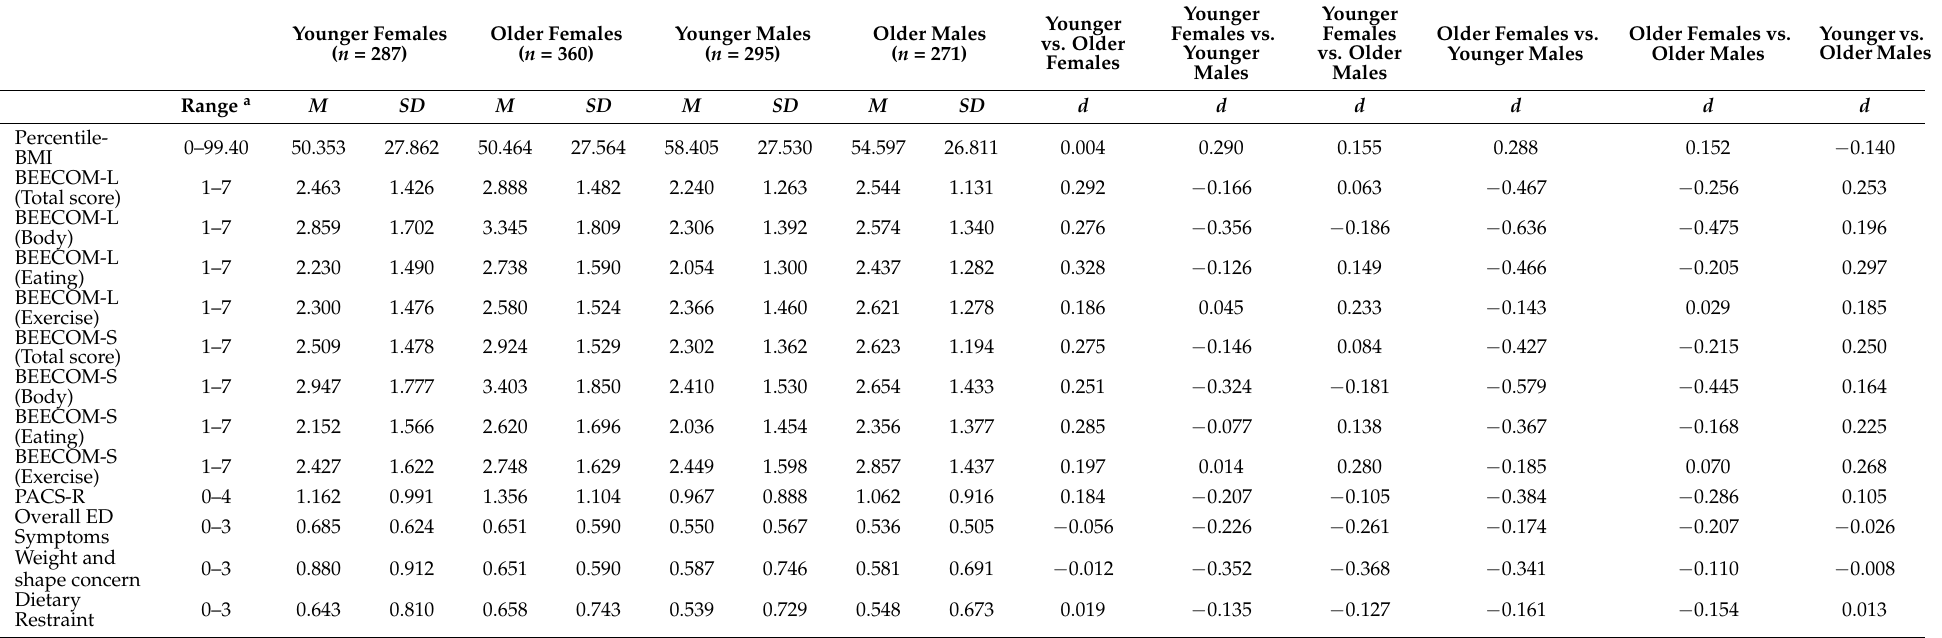
Table 3. Scores of Study Variables and Effect Sizes of Differences Across Population Subgroups. Younger Females ( n =